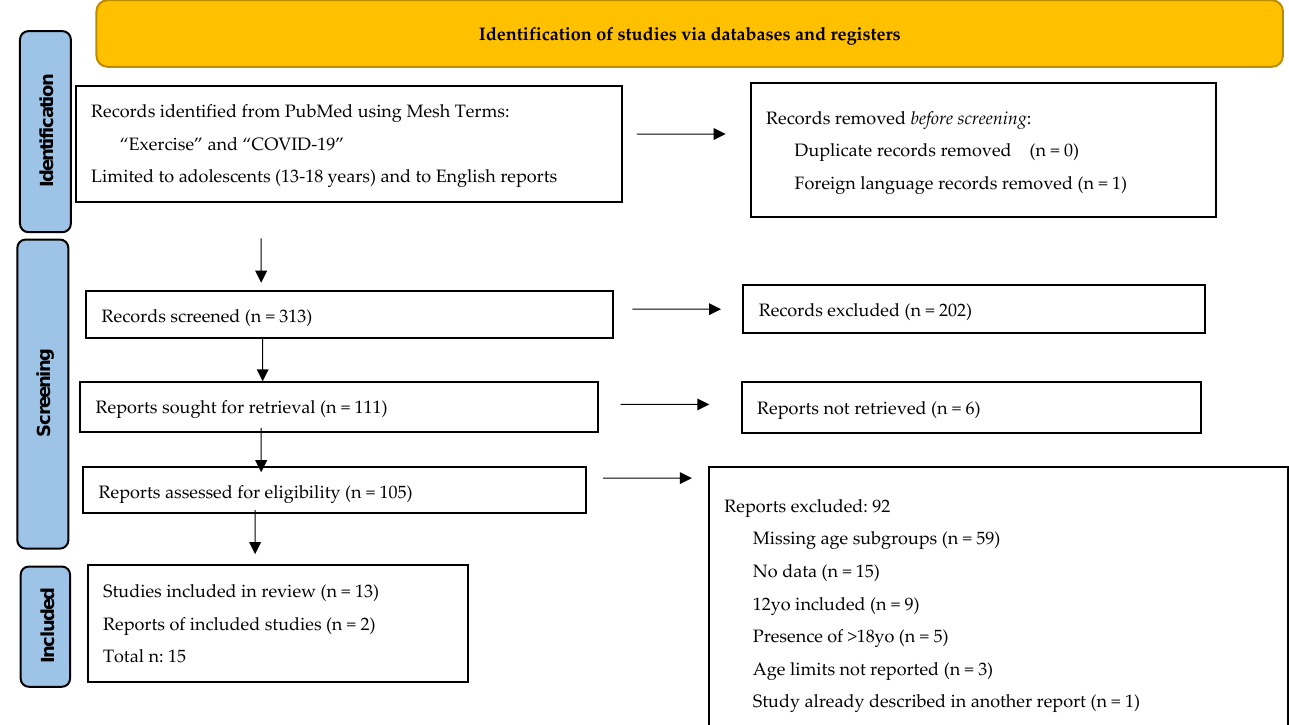
Diagram 1: flow chart of the selected process Figure 1. Flow chart of the selected